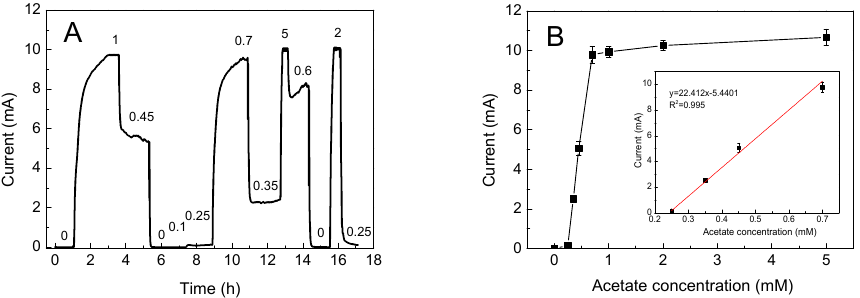
Figure 1. The use of the microbial fuel cell (MFC) sensor for organic matter detection: ( A ) the use of the MFC sensor for organic matter detection (0–5 mM) in a continuous flow-through mode; ( B ) the correlation of the output plateau current with the acetate concentration, which was used to select the typical background concentrations.